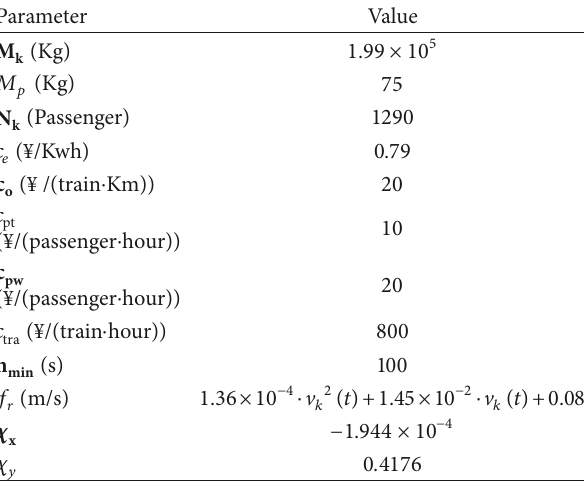
Table 3: Parameter values in the experiments.